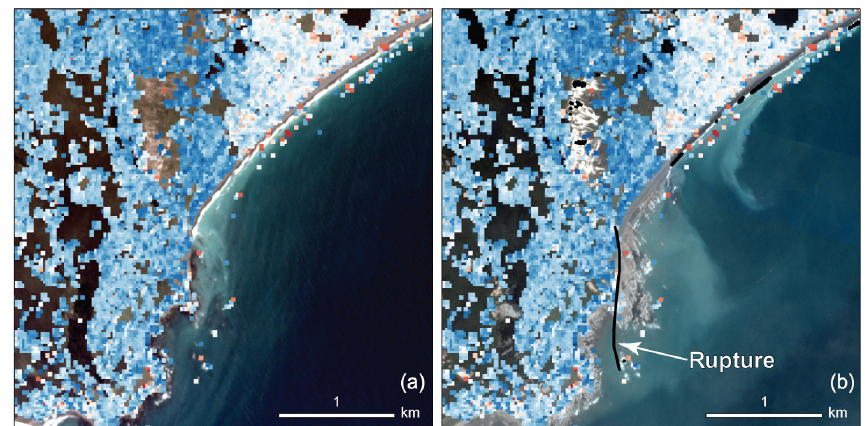
Figure 5. Horizontal surface displacements from PlanetScope images of 27 October–21 November 2016, W–E component. For colour scale see Fig. 3. (a) PlanetScope image of 27 October, (b) 21 November 2016. The section of uplifted seabed (right of the rupture) and the according rupture are visible in the PlanetScope images; the rupture is indicated by a black line that was digitized from the images. Location: C in Fig. 3.